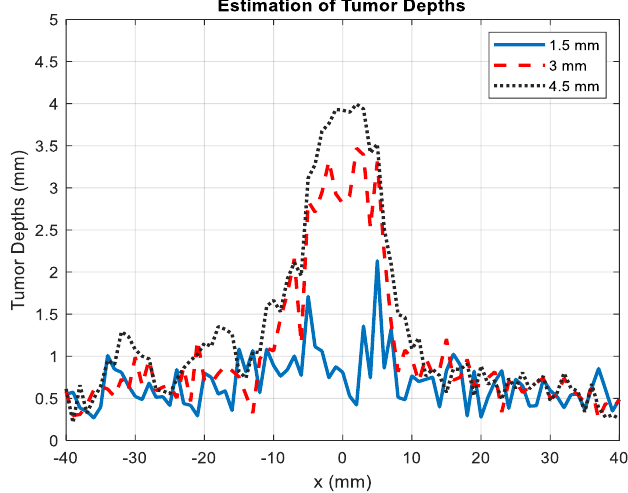
Figure 9. Depth estimation of the tumor for actual thicknesses of 1.5 mm, 3 mm, and 4.5 mm.